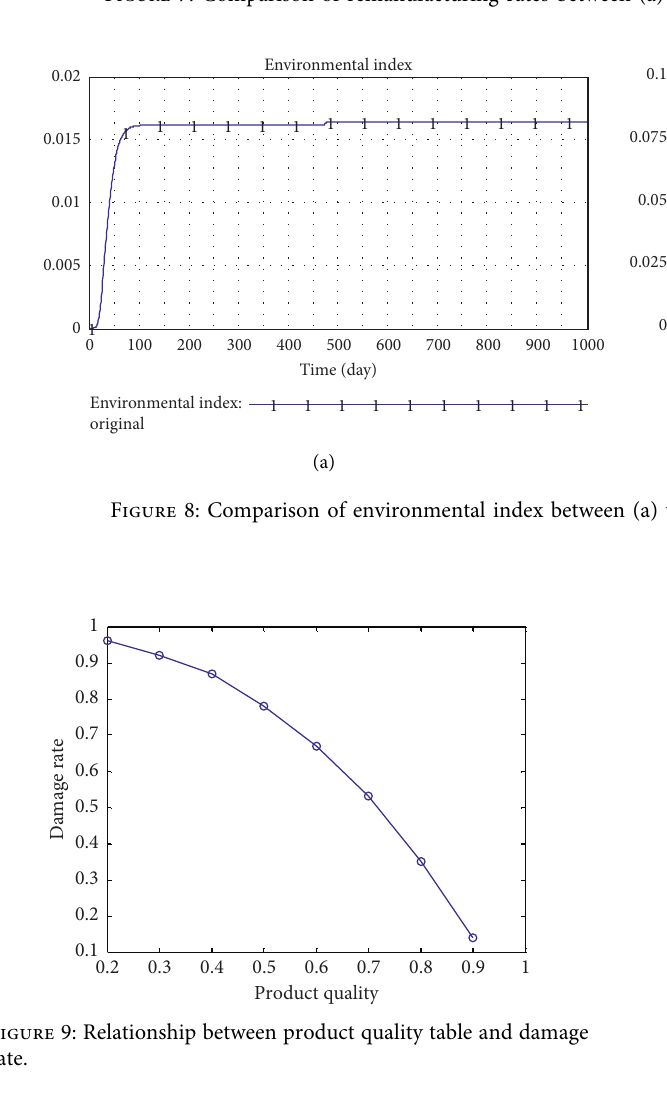
Figure 7: Comparison of remanufacturing rates between (a) the original model and (b) the improved model.